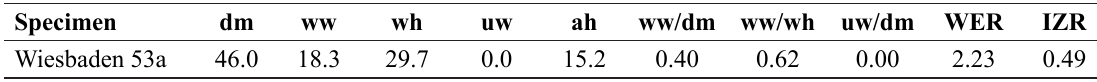
Table 1. Conch dimensions and ratios of Tornoceras typus (Sandberger & Sandberger, 1851), lectotype (Wiesbaden